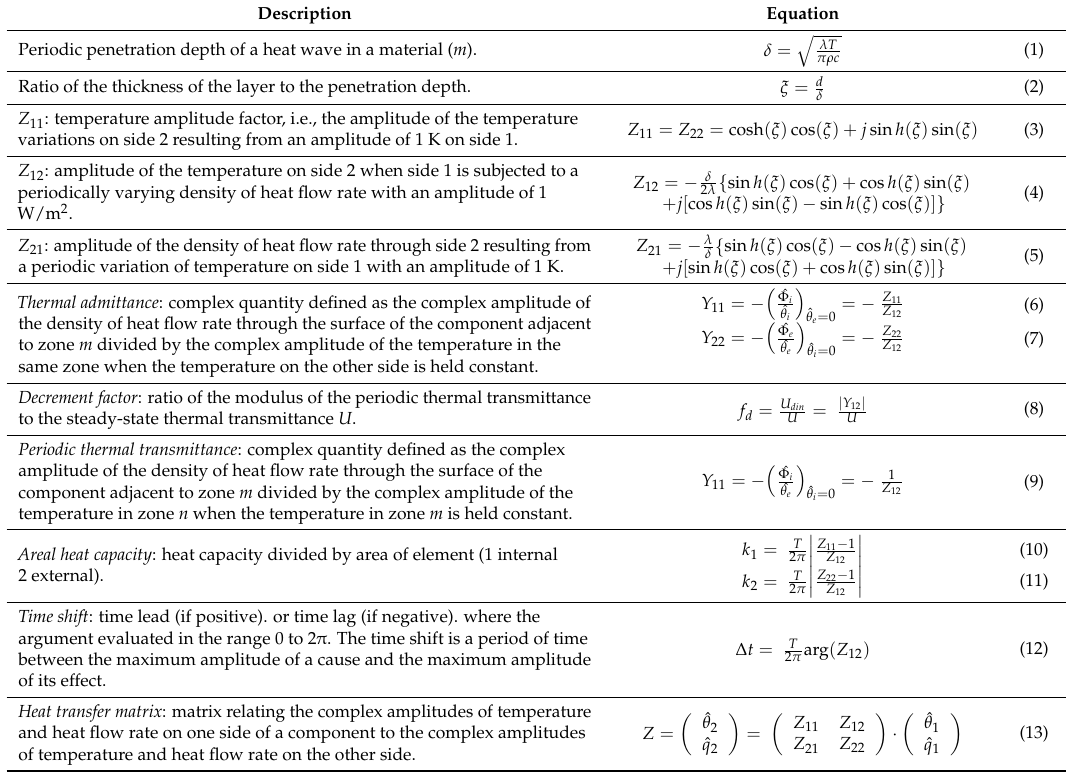
Table 1. Dynamic thermal characteristics of building